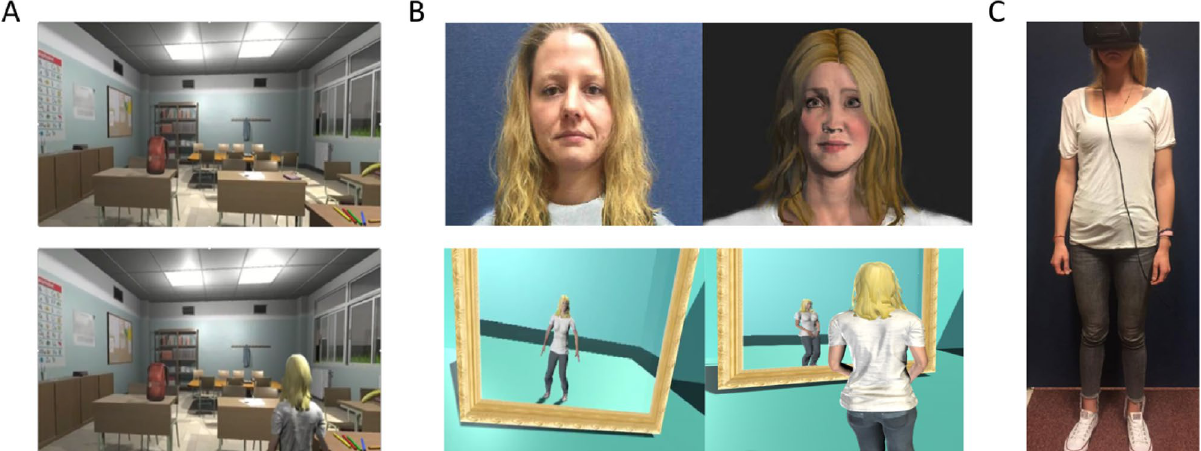
Figure 4. Study two virtual environment and avatars. ( A ) Examples of the first-person (above) and third- person (below) avatar perspectives when the camera field-of-view is controlled for. ( B ) Example of bespoke avatars created to physically resemble the participant (above) and mirror training environment from first- person (below left) and third-person (below right) avatar perspectives. ( C ) During the task, participants wore a white t-shirt and jeans to match the clothing worn by their bespoke virtual avatar, and a Kinect for Xbox was used to move the virtual avatar using their physical body movements. Written informed consent for open access publication was obtained for using this identifying